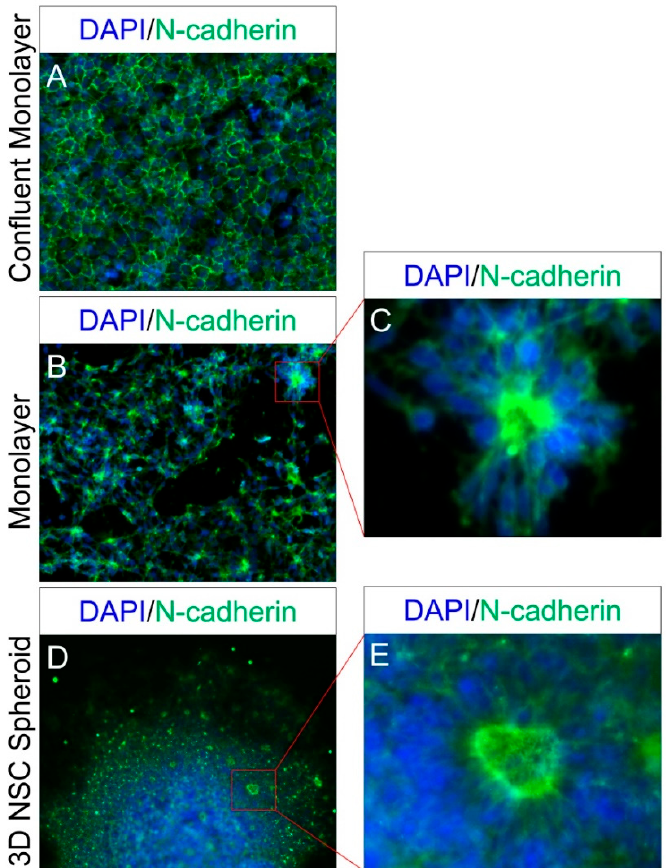
Figure 2. Apical-basal polarity characteristic of iPSC-generated NSCs. ( A ) Epithelial cells like localization of adherens junction’s protein N-cadherin in confluent NSC monolayer culture. ( B , C ) Acquisition of radial apical basal property and N-cadherin localization in NSC monolayer culture. ( D , E ) Self-organization of differentiated NSCs into neural rosettes like structures in a 3D NSC spheroid culture.